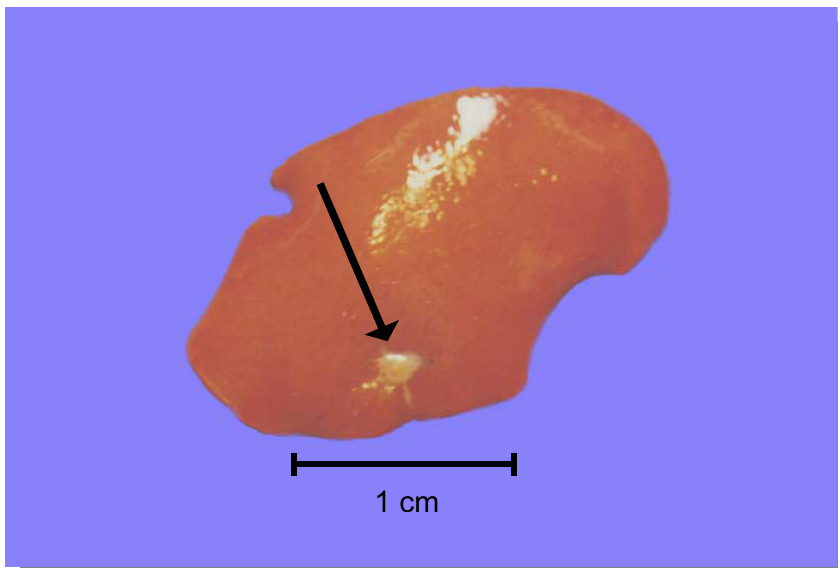
1 cm FIGURA 5 – Aspecto macroscópico do fígado de coelho decorridos 14 dias da injeção de solução de ácido acetilsalicílico 5%. Notar área cicatricial (seta)